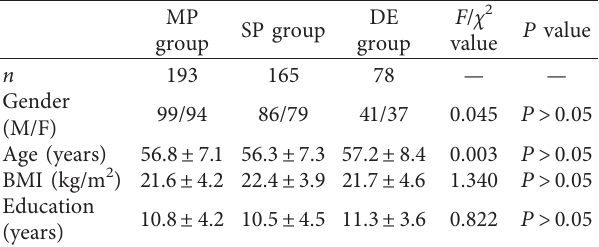
Table 1: General information of three groups of